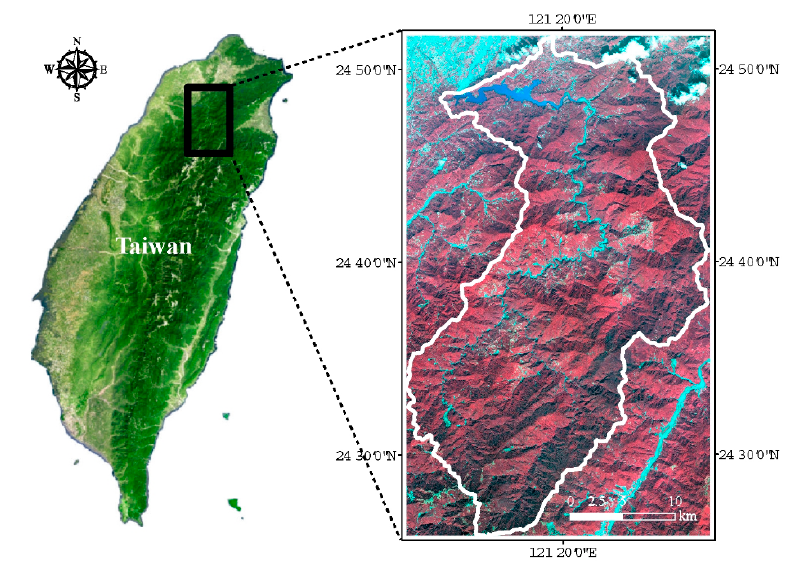
Figure 1. The location of the study area and a corresponding SPOT false-color satellite image.